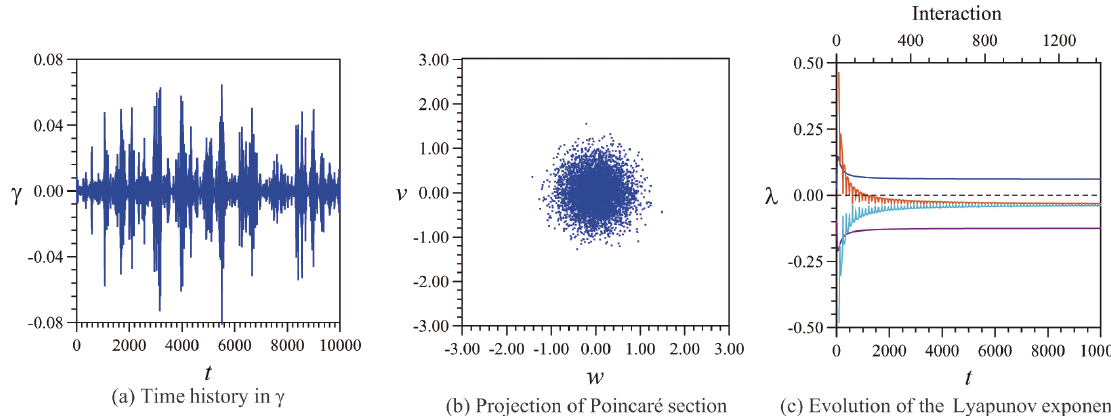
Fig. 8. Characteristic chaotic response for high forcing magnitudes. Ω u = 2 ω 0 and q u =